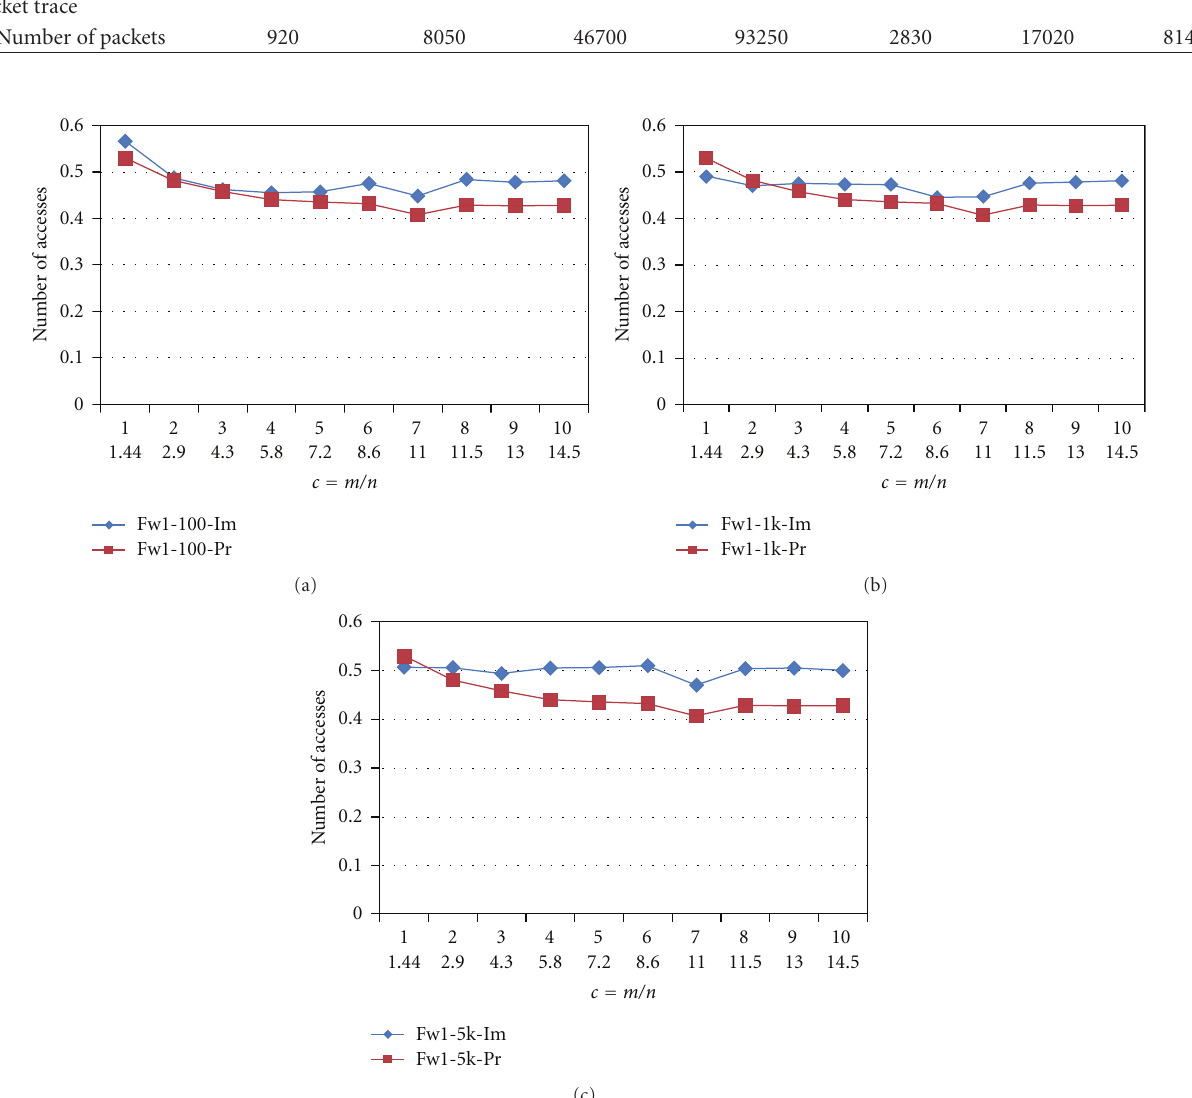
Figure 6: The number of accesses in CCBF normalized to the number of accesses in standard Bloom filter includes mathematical analysis and software implementation. (a) The number of accesses in a 3-level CCBF for Fw1-100. (b) The number of accesses in a 3-level CCBF for Fw1-1k. (c) The number of accesses in a 3-level CCBF for